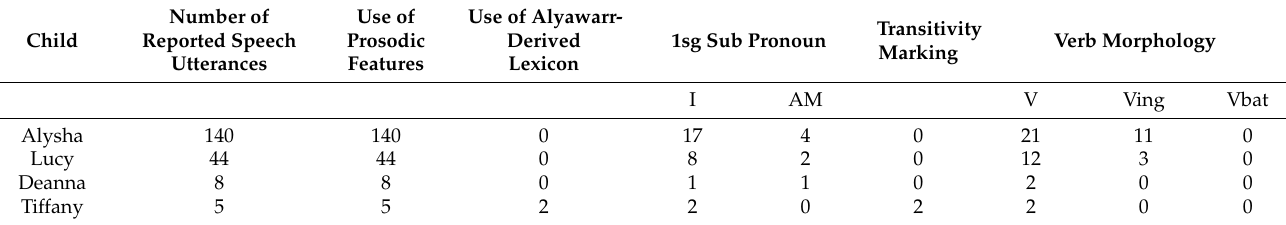
Table A2. Number of tokens of each linguistic element, per